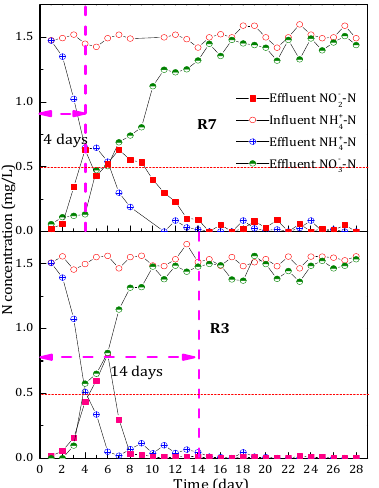
Figure 8. The effect of dosing time on the variation of N (NH 4+ -N, NO 3 − -N and NO 2 − -N) concentration during the start-up period.